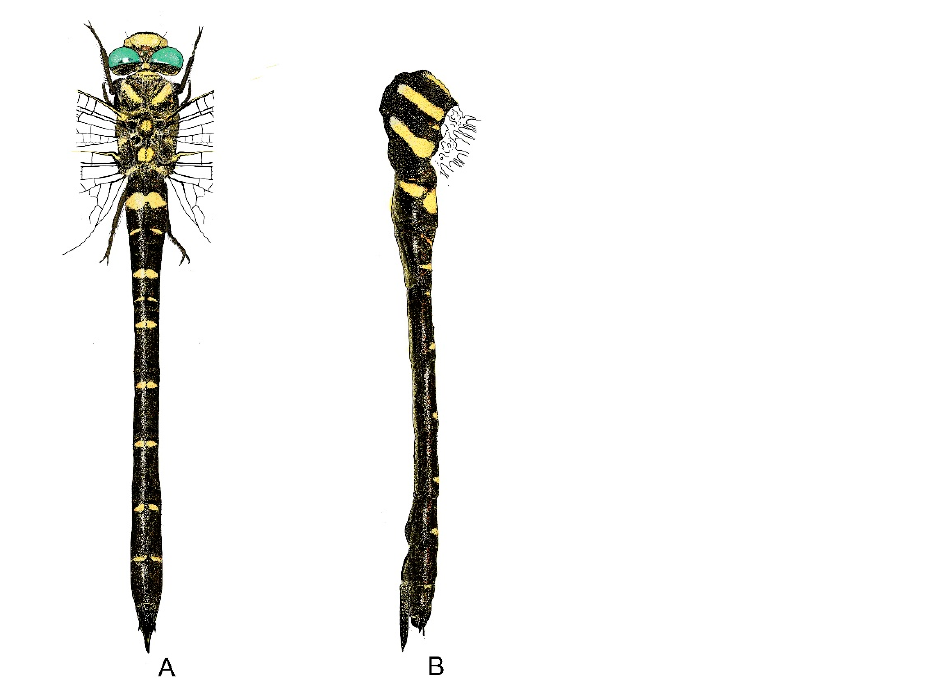
Figure 19. Cordulegaster mzymtae, ♀ (collection Elias and Thomas Schneider, leg. Thomas Schneider, 30 July 2015, Georgia, Adjara, 5 km E Goderdzi Pass, 41.6319° N, 42.5680° E, 1820 m a.s.l.): ( A ): habitus, dorsal. ( B ): habitus, lateral. Thorax (Figure 19A,B): much as in male, exception the yellow markings of metepister- num; metepisternum black with small comma-shaped yellow markings, Wings : much as in male, hyaline; Pt black, Pt FW 4.0 × 0.5, HW 4.1 × 0.6. Abdomen (Figure 19A,B): cylindrical and thicker than in males, ovipositor 5.3 mm, black, only slightly curved, almost straight and